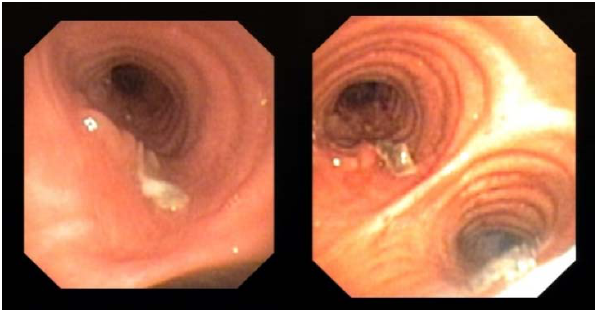
Figure 1. Evidence of mucosal infiltration and pseudomembranes in the left main bronchus, in a COVID-19 associated pulmonary aspergillosis (CAPA). The patient underwent a bronchial biopsy for the histological